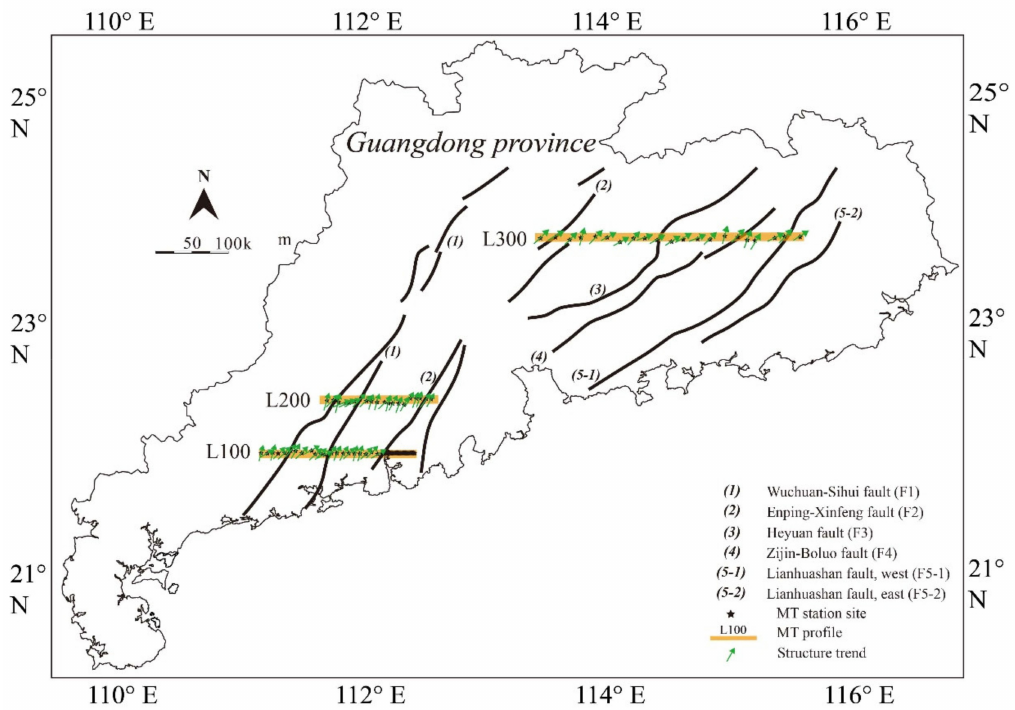
Figure 4. The structural trend of the survey points in the three profiles. The orange lines are major regional deep-seated fault, the yellow line is the MT profile, the pink arrow is the structure trend, and the black star is the MT